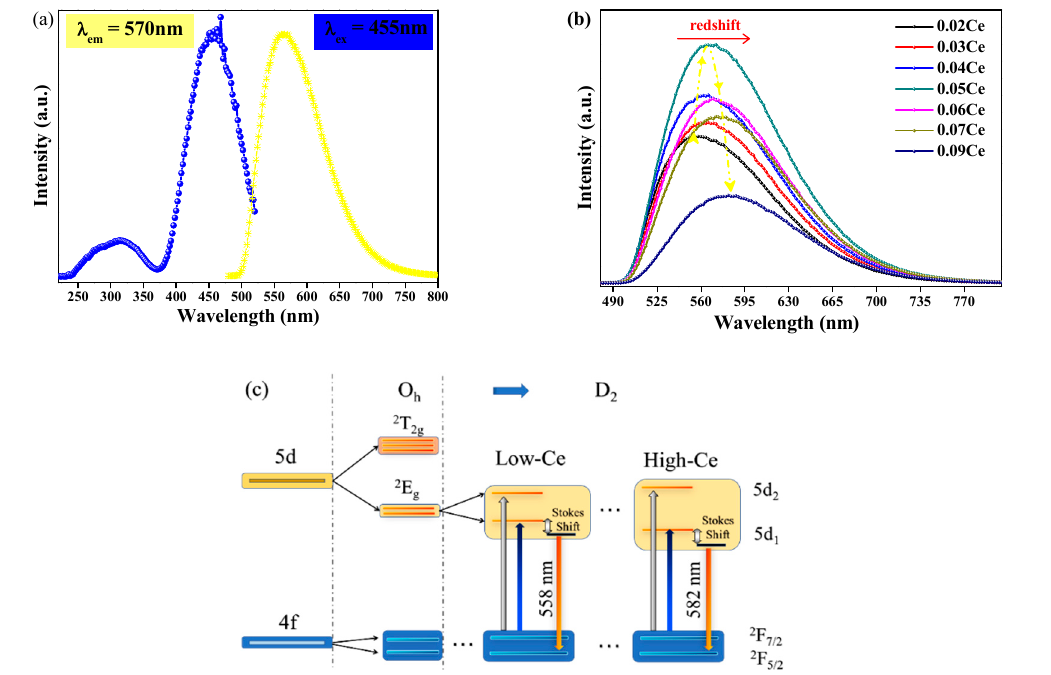
Figure 3. ( a ) The PL ( λ ex = 455 nm) and PLE ( λ em = 570 nm) spectra of YMASG:0.05Ce 3+ . ( b ) The PL ( λ ex = 455 nm) spectra of YMASG:xCe 3+ (x = 0.01, 0.03, 0.04, 0.05, and 0.09). ( c ) The crystal field splitting and the energy level diagram of Ce 3+ ion in YMASG during the substitution of Y 3+ /Mg 2+ ions.